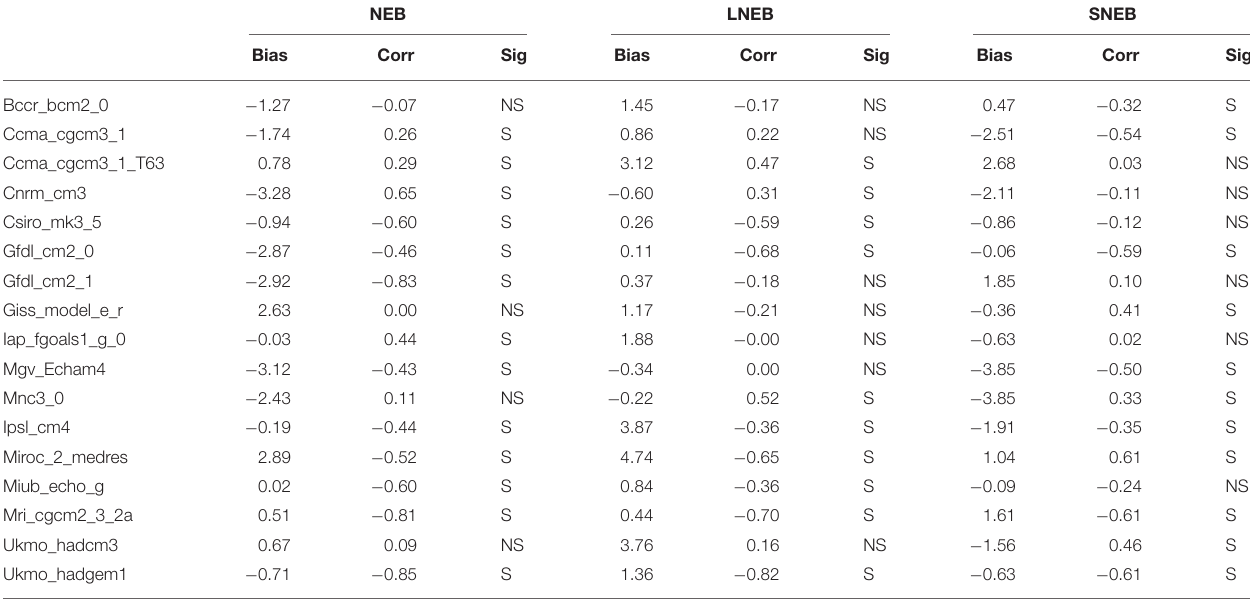
TABLE 1 | Correlation and bias between the summer rainfall simulated by the CMIP3 models and the observations in CMAP.